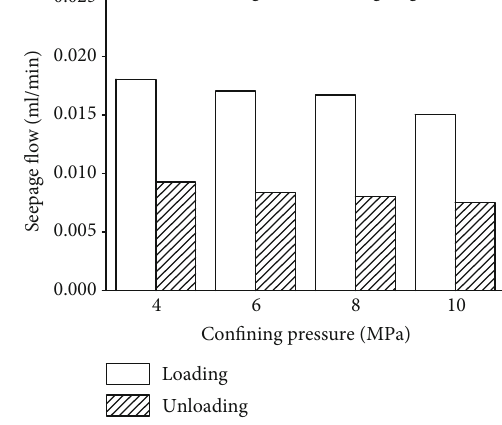
Figure 10: Comparison of seepage fl ow in cyclic loading-unloading con fi ning process of postpeak fractured